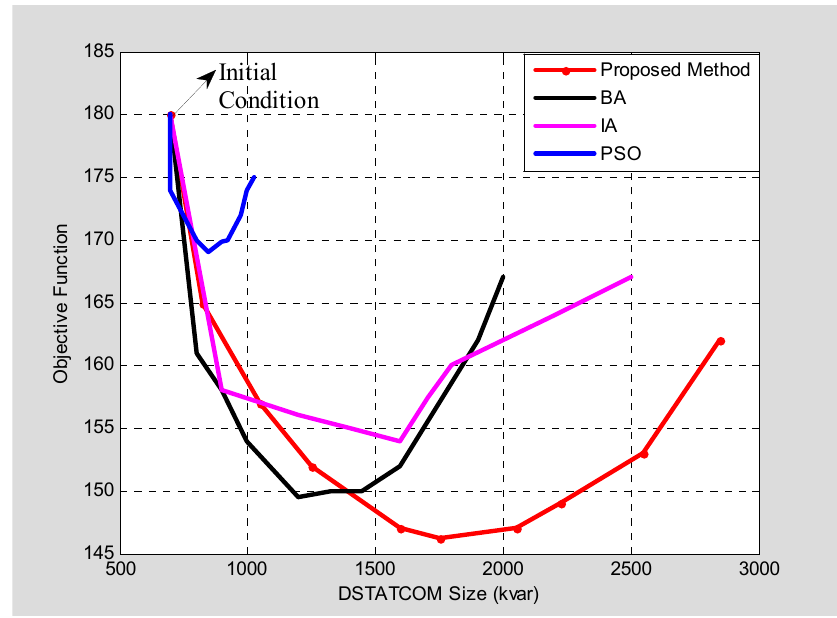
Figure 10. Performance of di ff erent methods for standard 69-bus system.